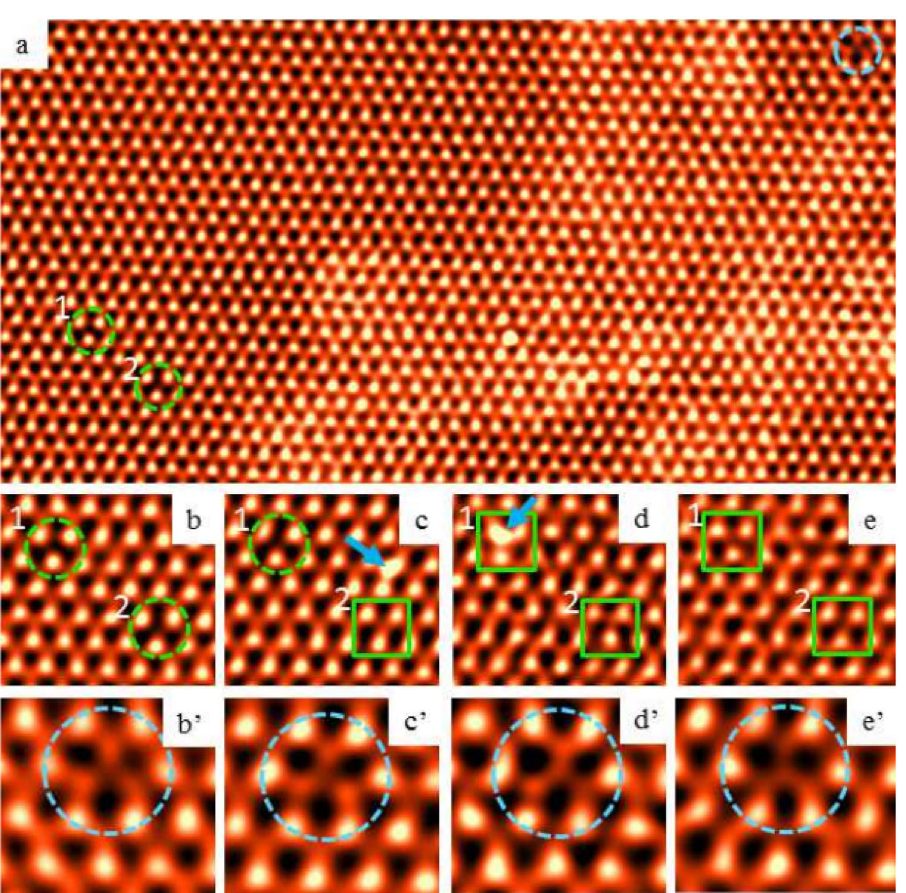
Figure 6. ADF-STEM images showing S vacancy replenishment. ( a ) is an overview of the area of MoS 2 films that was repetitively scanned, taken at the beginning of the continuous acquisition. Blue dotted circle indicates a Mo deficient site, green dotted circles indicate two S vacancy sites. ( b ) is cropped from ( a ) to show S vacancy sites 1 and 2 at the beginning of acquisition (t = 0). ( c ) is acquired 225 s after ( b ), showing an adatom (blue arrow) and re-occupied site (green square). ( d ) is acquired 300 s after ( c ), showing an adatom at site 1. ( e ) is acquired 225 s after ( d ), showing sites 1 and 2 both occupied by an adatom. (b’–e’) are taken from the same images as ( b – e ), respectively, showing Mo deficient site that did not change during